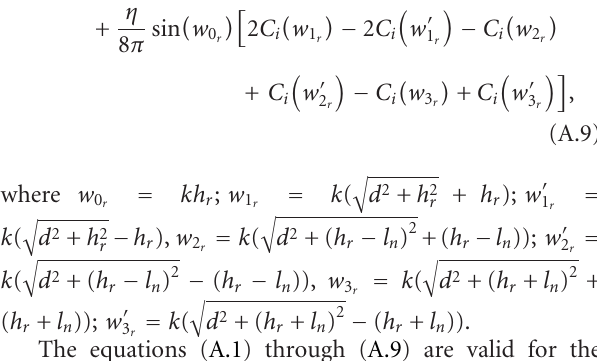
Parallel-in-echelon